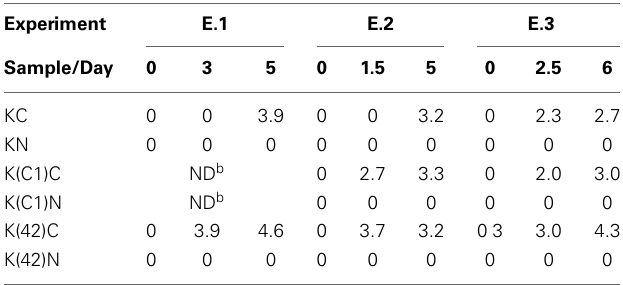
Table 2 | Spore levels as log cfu/ml a on BHI agar for B. weihenstephanensis KBAB4 (K) grown in mono- or in co-cultures with the Pseudomonas raw milk isolate C1 or with P. tolaasii LMG 2342 T (42) at 25 ◦ C in BHI